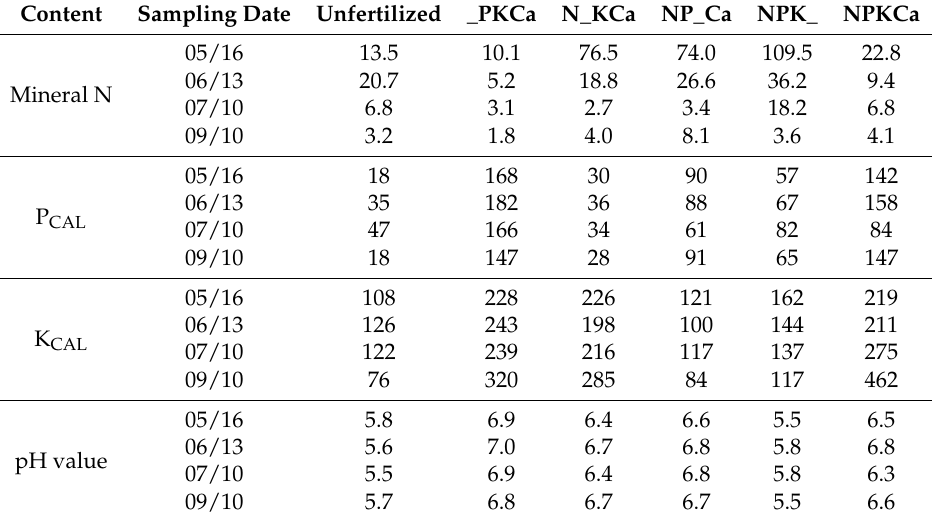
Table 2. Soil analysis data. Topsoil mineral N, plant available soil P and K (P CAL and K CAL ) extracted with a calcium-acetate-lactate extract in kg ha − 1 and topsoil pH values for the seven treatments and four sampling dates in 2019 at the long-term fertilizer experiment Dikopshof. 07/10 denotes 10 July 2019, where 2019 is omitted for